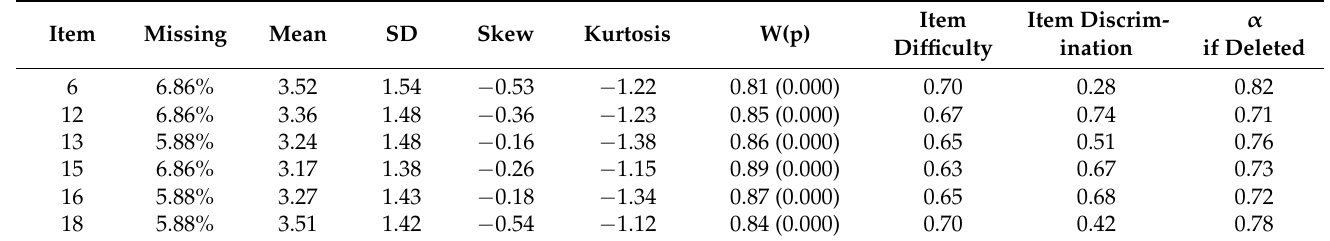
Table 6. Rasch analysis of the dimension 3 of the SCOOHPI.